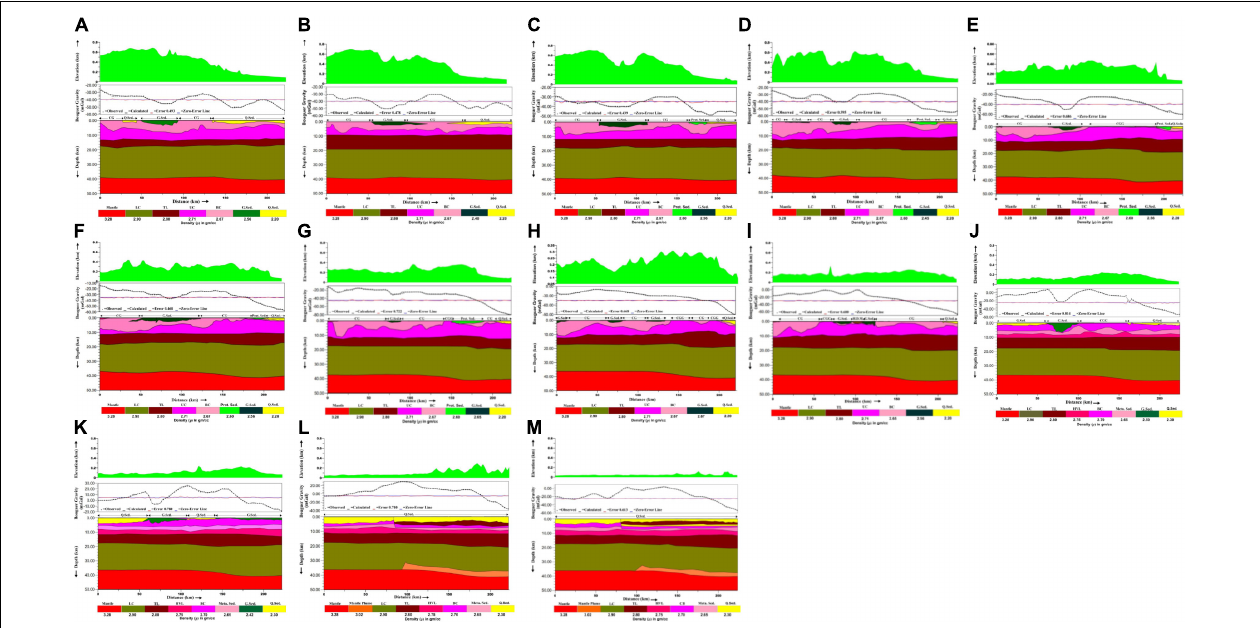
FIGURE 6 | (A) 2D gravity model along profile AA (cid:48) (at longitude 84.75 ◦ E), location of the profile is shown in Figure 3 . Abbreviations: CG, Chhotanagpur granite; CGG, Chhotanagpur granite gneiss; Q. Sed., quaternary sediment; G. Sed., Gondwana sediment; Prot. Sed., proterozoic sediment; LC, lower crust; TL, transition layer; UC, upper crust; BC, basement complex. (B) 2D gravity model along profile BB (cid:48) (at longitude 85.00 ◦ E), location of the profile is shown in Figure 3 . (C) 2D gravity model along profile CC (cid:48) (at longitude 85.25 ◦ E), location of the profile is shown in Figure 3 . (D) 2D gravity model along profile DD (cid:48) (at longitude 85.50 ◦ E), location of the profile is shown in Figure 3 . (E) 2D gravity model along profile EE (cid:48) (at longitude 85.75 ◦ E), location of the profile is shown in Figure 3 . (F) 2D gravity model along profile FF (cid:48) (at longitude 86.00 ◦ E), location of the profile is shown in Figure 3 . (G) 2D gravity model along profile GG (cid:48) (at longitude 86.25 ◦ E), location of the profile is shown in Figure 3 . (H) 2D gravity model along profile HH (cid:48) (at longitude 86.50 ◦ E), location of the profile is shown in Figure 3 . (I) 2D gravity model along profile II (cid:48) (at longitude 86.75 ◦ E), location of the profile is shown in Figure 3 . (J) 2D gravity model along profile JJ (cid:48) (at longitude 87.00 ◦ E), location of the profile is shown in Figure 3 . (K) 2D gravity model along profile KK (cid:48) (at longitude 87.25 ◦ E), location of the profile is shown in Figure 3 . (L) 2D gravity model along profile LL (cid:48) (at longitude 87.50 ◦ E), location of the profile is shown in Figure 3 . (M) 2D gravity model along profile MM (cid:48) (at longitude 87.75 ◦ E), location of the profile is shown in